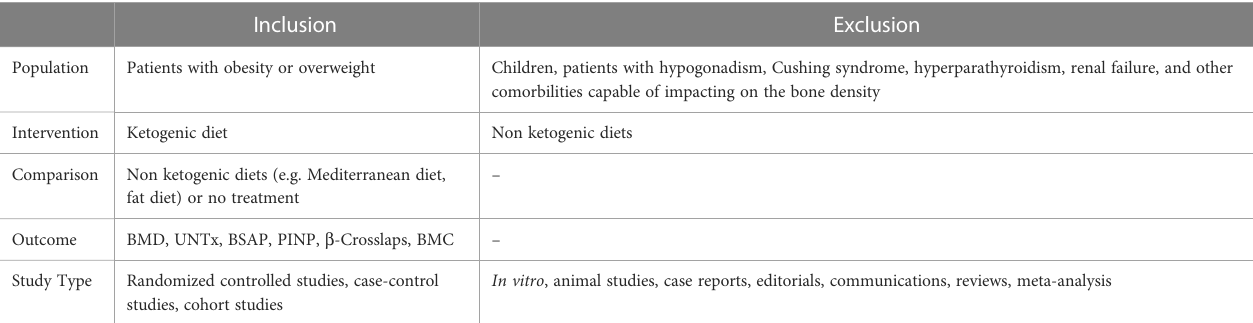
TABLE 1 Inclusion and exclusion criteria of the current systematic review, according to the PICOS model (15).